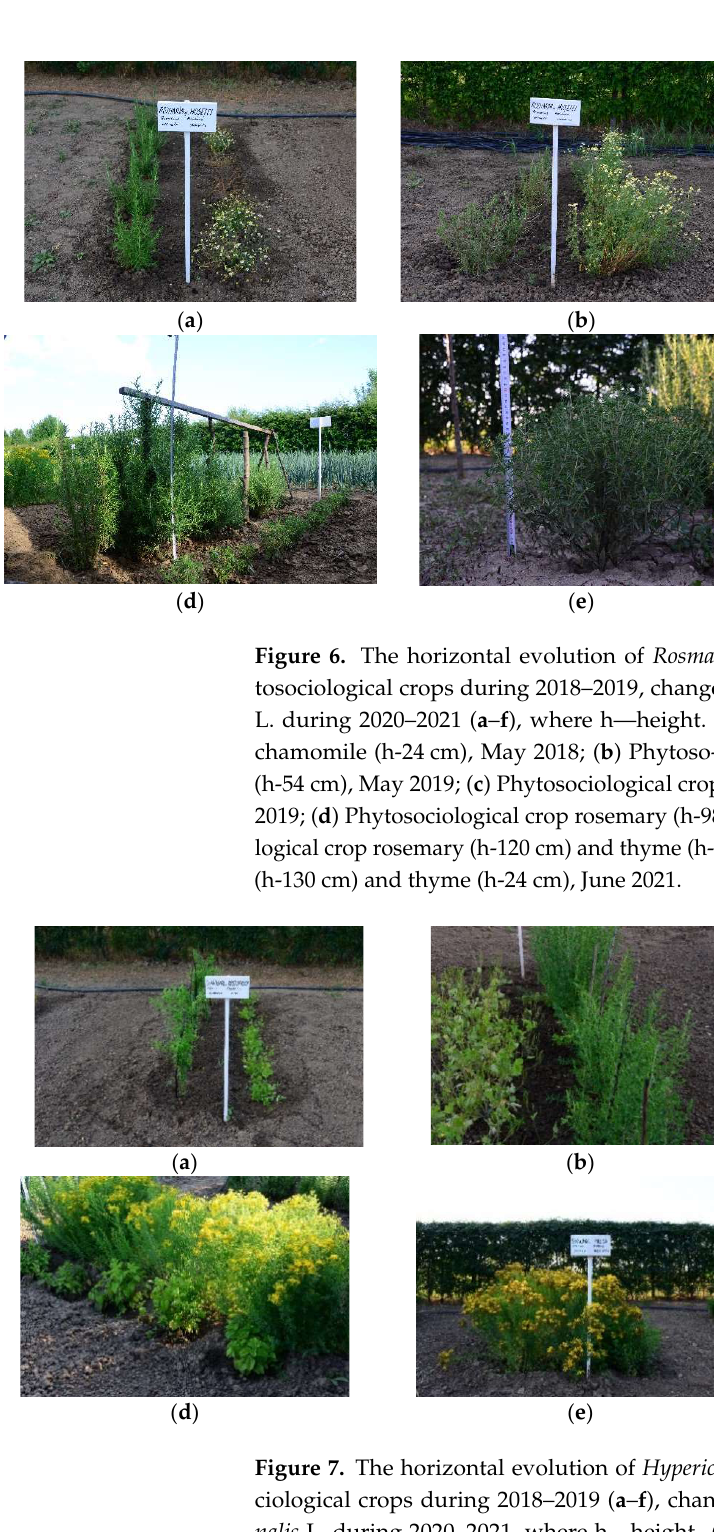
Figure 7. The horizontal evolution of Hypericum perforatum L. and Chelidonium majus L. phytosociological crops during 2018–2019 ( a – f ), changed with Hypericum perforatum L. and Melissa officinalis L. during 2020–2021, where h—height. (a) Phytosociological crop St. John’s Wort (h-60 cm) and celandine (h-25 cm), May 2018; (b) Phytosociological crop St. John’s Wort (h-73 cm) and celandine (h-52 cm), May 2019; (c) Phytosociological crop St. John’s Wort (h-93 cm) and celandine (h-58 cm) June 2019; (d) Phytosociological crop St. John’s Wort (h-74 cm) and lemon balm (h-28 cm), May 2020; (e) Phytosociological crop St. John’s Wort (h-78 cm) and lemon balm (h-52 cm), June 2020; (f) Phytosociological crop St. John’s Wort (h-82 cm) and lemon balm (h-56 cm), June 2021. Figure 8 represents a panoramic characterization of the evolution of the crops in 2019–2021, and Figure 9 shows graphically the evolution of the rest of medicinal plants for the entire study period.